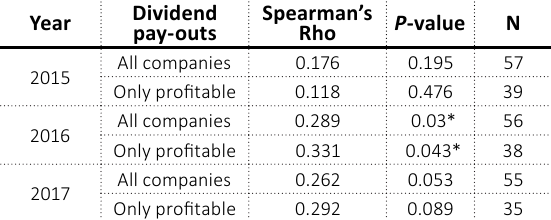
Table 3. Correlations between Corporate Governance Index and dividend